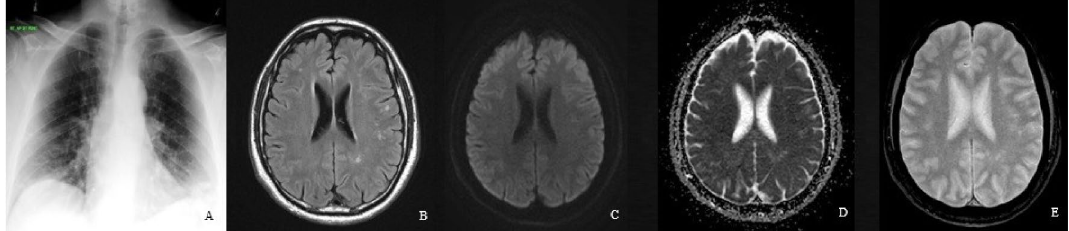
Figure 6. Thirty-three-year-old male, admitted with RT-proved SARS-CoV-2 pneumonia, ( A ) as noted on the chest radiogram. With GCS = 15, this patient developed headache and blurred vision. Brain MRI showed nonspecific scattered deep and sub-cortical small foci, in bilateral frontal and right parietal lobes with ( B ) hyperintense signals on axial FLAIR image. ( C ) DW-MRI, and ( D ) corresponding ADC map showed no diffusion restriction. ( E ) Also, no blooming was depicted on 2D T 2 * GRE image.